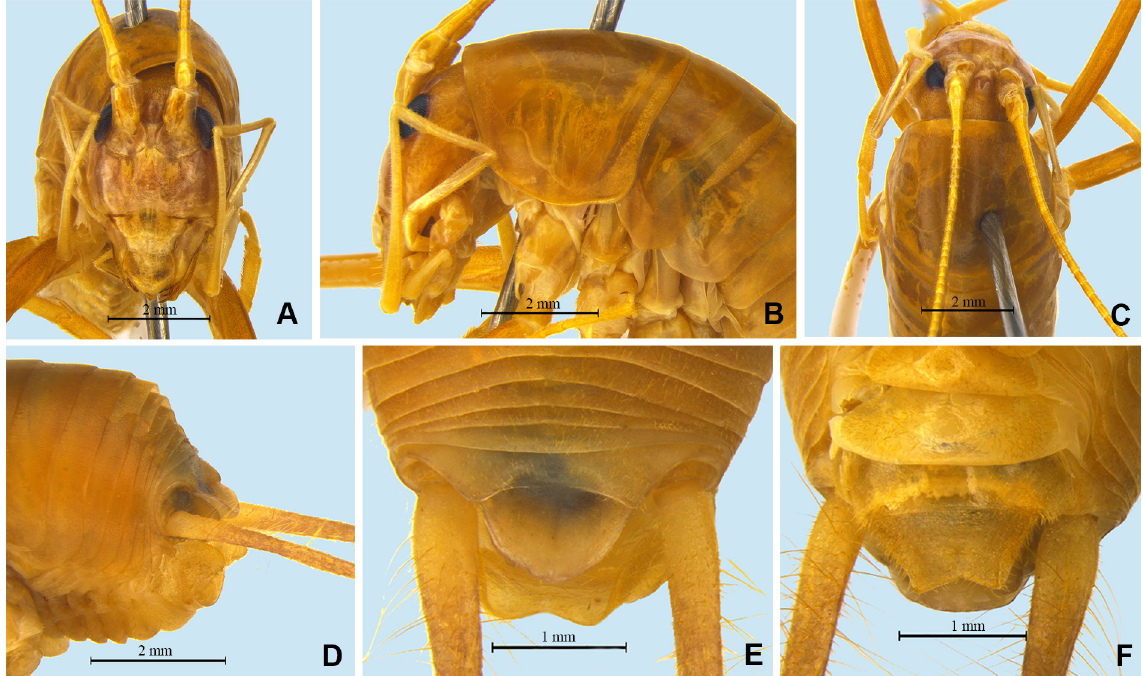
Fig. 2. Tachycines ( Gymnaeta ) shiziensis sp. nov. A–F . Holotype, ♂ (HBU). A–C . Head and pronotum. A . Frontal view. B . Lateral view. C . Dorsal view. D–F . Apex of abdomen. D . Lateral view. E . Dorsal view. F . Ventral